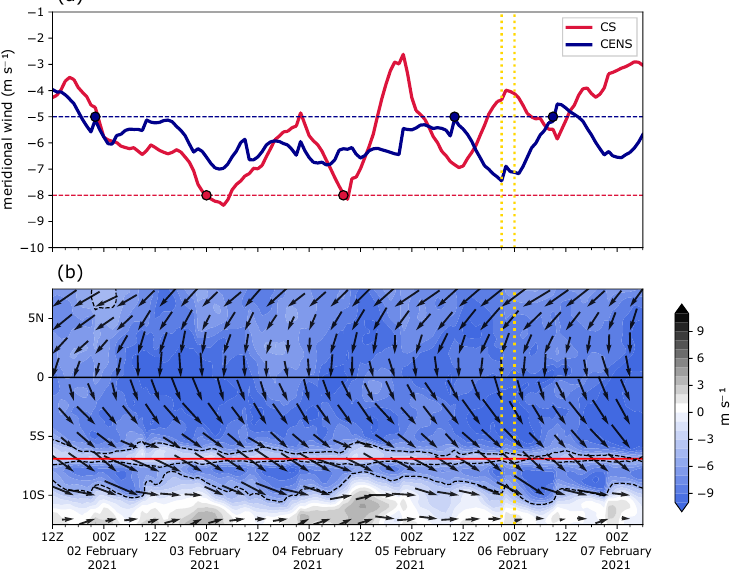
Figure 7. ( a ) Time series of cross equatorial northerly surge (CENS) (blue line) and cold surge (CS) (red line), the horizontal-dashed line indicates the threshold of an activated mode of CENS and CS. ( b ) Time-latitude of 925 hPa horizontal wind magnitude and direction (arrows), contour-fill represents meridional wind and the dotted line shows the value of 5 m/s, the red line marks the latitude of Semarang coastline, the vertical yellow line marks the rainfall peaks. Both ( a ) and ( b ) x-axis span from 12Z 2 February to 03Z 7 February